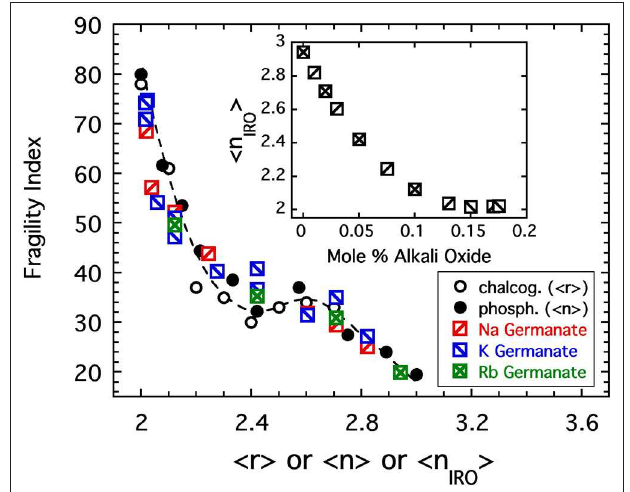
FIGURE 9 | The fragility index of sodium, potassium, and rubidium germanate glasses (Nemilov, 1970; Shelby, 1974), is plotted as a function of the connectivity coarse-grained to include IRO structures as described in the text. Also shown are the data from Figure 4 for both the chalcogenides (plotted as a function of the average bond per atom) and the alkali phosphates (plotted as a function of the average BO per phosphate). The inset shows how the coarse-grained connectivity decreases rapidly with increasing alkali oxide addition.